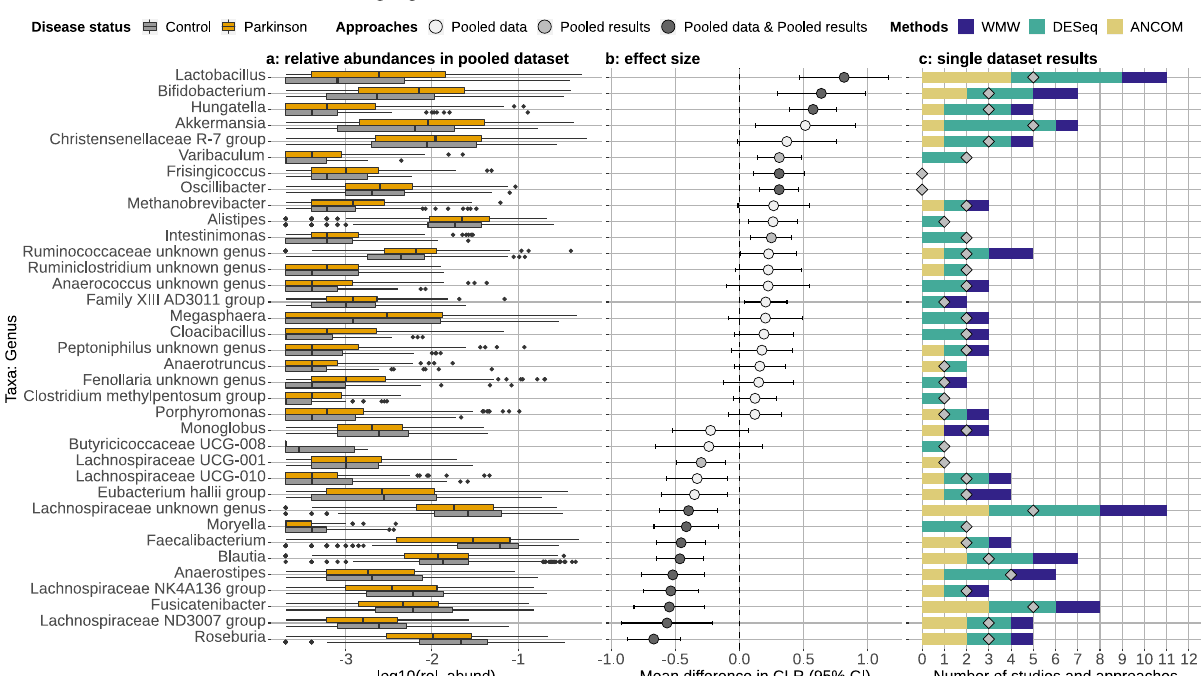
Fig. 5 Genera showing a signi fi cant difference in abundance between PD patients and controls. The relative abundances of the genera retrieved from the rare fi ed pooled data are reported in panel a . Effect sizes were estimated via the mean difference in CLR (panel b ) using a random-effect meta-analysis approach (Pooled results approach). This was calculated for all taxa resulting differentially abundant in the Pooled results or Pooled data approaches. The color of the dots indicates which of the two above approaches detected the taxa differentially abundant. Taxa more abundant in controls have an effect size shifted to the left, whereas taxa more abundant in PD have an effect size shifted to the right. Panel c shows the number of times each genus was detected differentially abundant between PD patients and control samples across studies (diamonds) and approaches (bars). We used ten studies and three approaches, hence the maximum number of times a taxon can be detected differentially abundant is